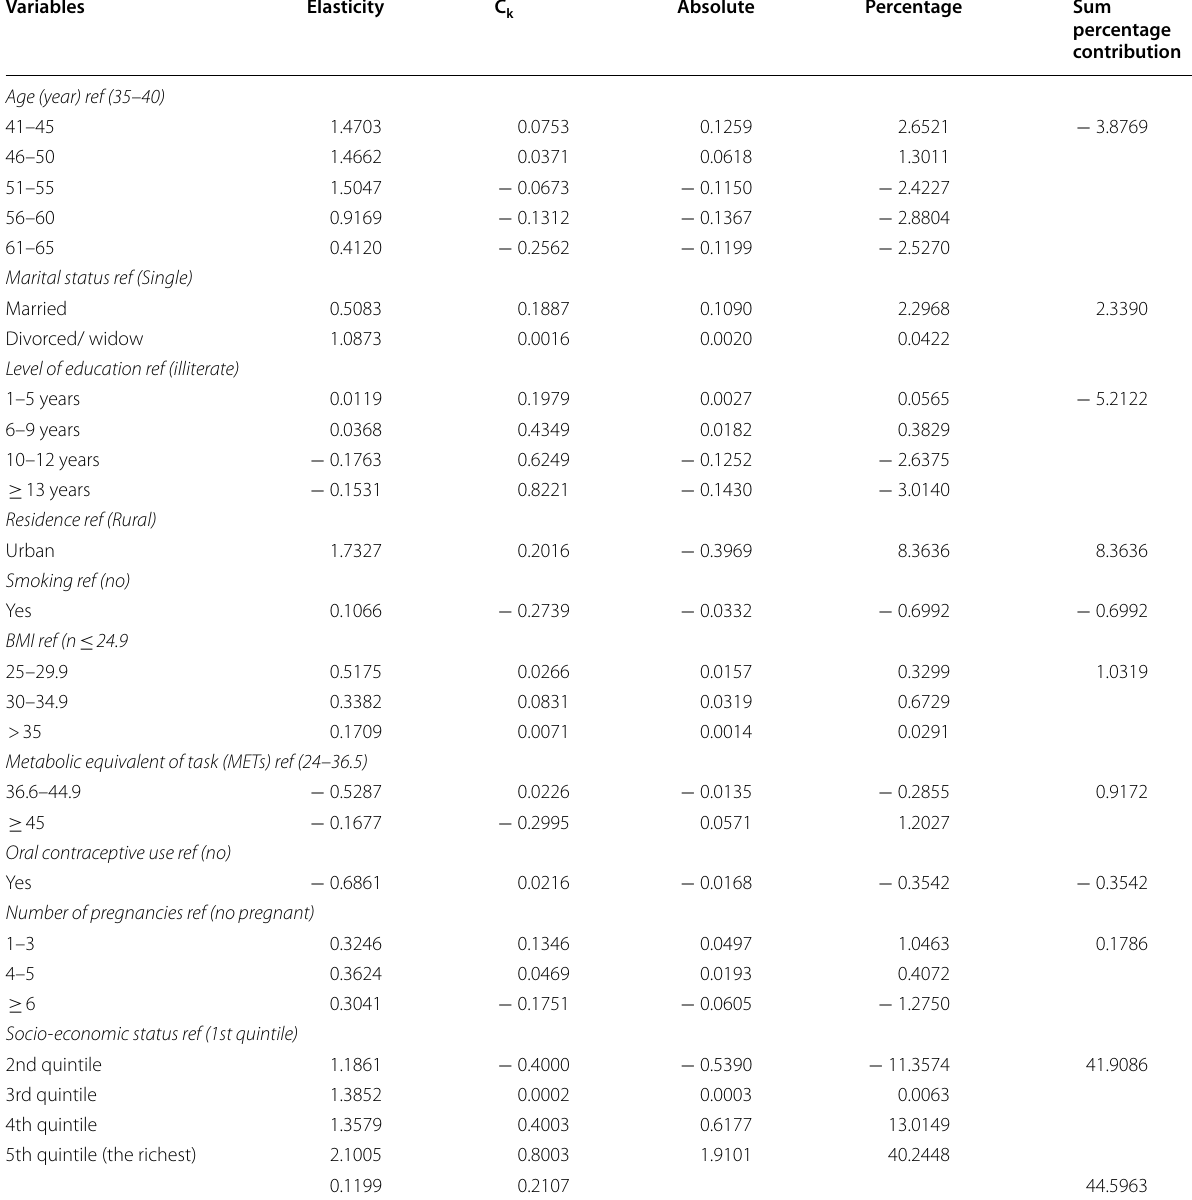
Table 3 Decomposition of socioeconomic‑related inequality towards mammography uptake